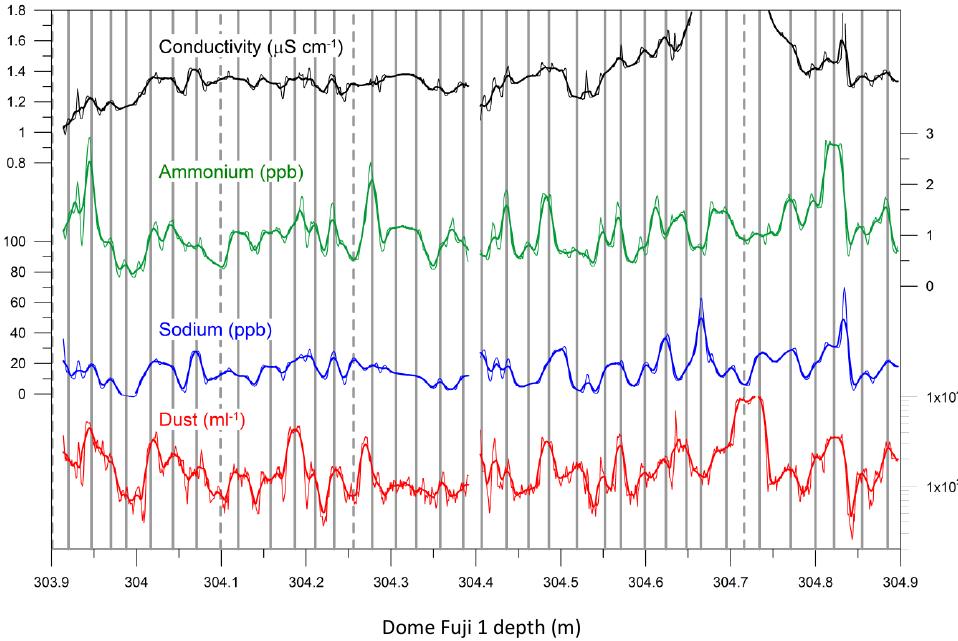
Figure 3. Example of high-resolution profiles of electrolytic conductivity, ammonium, sodium, and dust concentrations. Thin curves show the records at a 1mm depth resolution and thicker curves are 1cm averages. “Certain” and “uncertain” annual layer marks are indicated with full and dashed vertical lines, respectively. The entire data set is shown in the Supplement Figs. S1–S5.